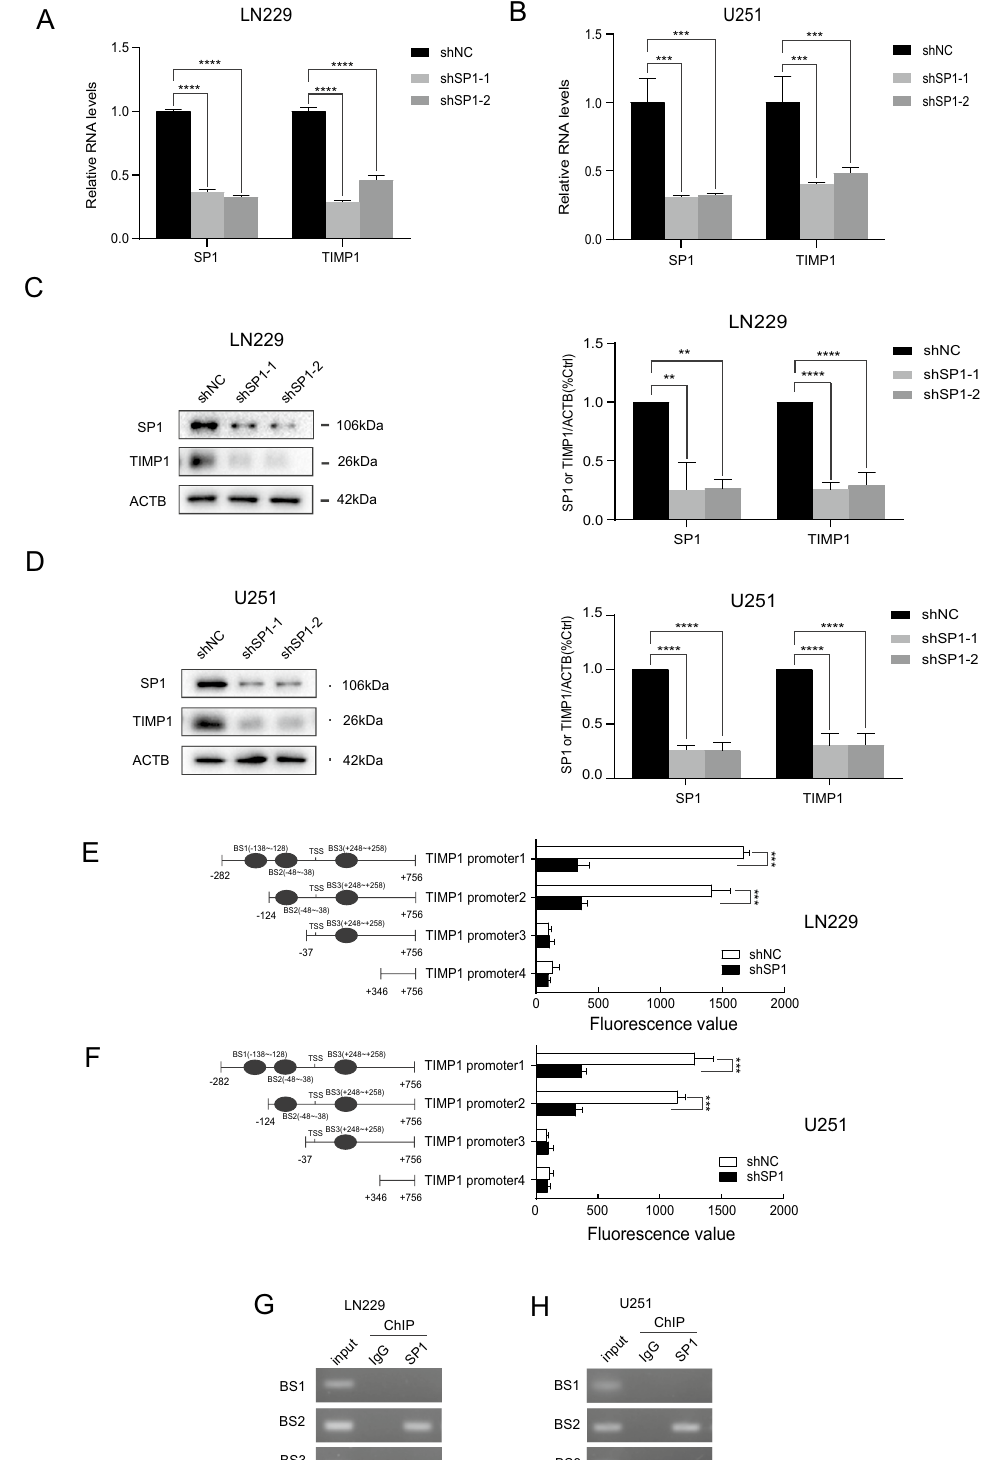
Figure 7. Sp1 binds to the TIMP1 promoter region and regulates TIMP1 expression in GBM. ( A ) Sp1 and TIMP1 mRNA levels in LN229 cells with stable Sp1 knockdown were detected by qPCR. n = 3 independent experiments. ( B ) Sp1 and TIMP1 mRNA levels in U251 cells with stable Sp1 knockdown were detected by qPCR. n = 3 independent experiments. ( C ) Sp1 and TIMP1 protein levels in LN229 cells with stable Sp1 knockdown were detected by western blot. ACTB was blotted as an internal (loading) control. n = 3 independent experiments. ( D ) Sp1 and TIMP1 protein levels in U251 cells with stable Sp1 knockdown were detected by western blot. ACTB was blotted as an internal (loading) control. n = 3 independent experiments. ( E,F ) Fragments of TIMP1 promoter in the luciferase reporter plasmids (left). The activity of the different fragments of TIMP1 promoter was determined by dual-luciferase assay, n = 3 independent experiments (right); ( G,H ) Binding of Sp1 to TIMP1 promoter was examined by ChIP assay. Data were presented as mean ± s.d. of three independent experiments. ( A,B ) and ( C,D ) Right panel were analyzed by onE−way ANOVA + two-side Dunnett test, ** P < 0.01, *** P < 0.001, **** P < 0.0001. ( E,F ) were analyzed by two-side Student’s t -tset, *** P <